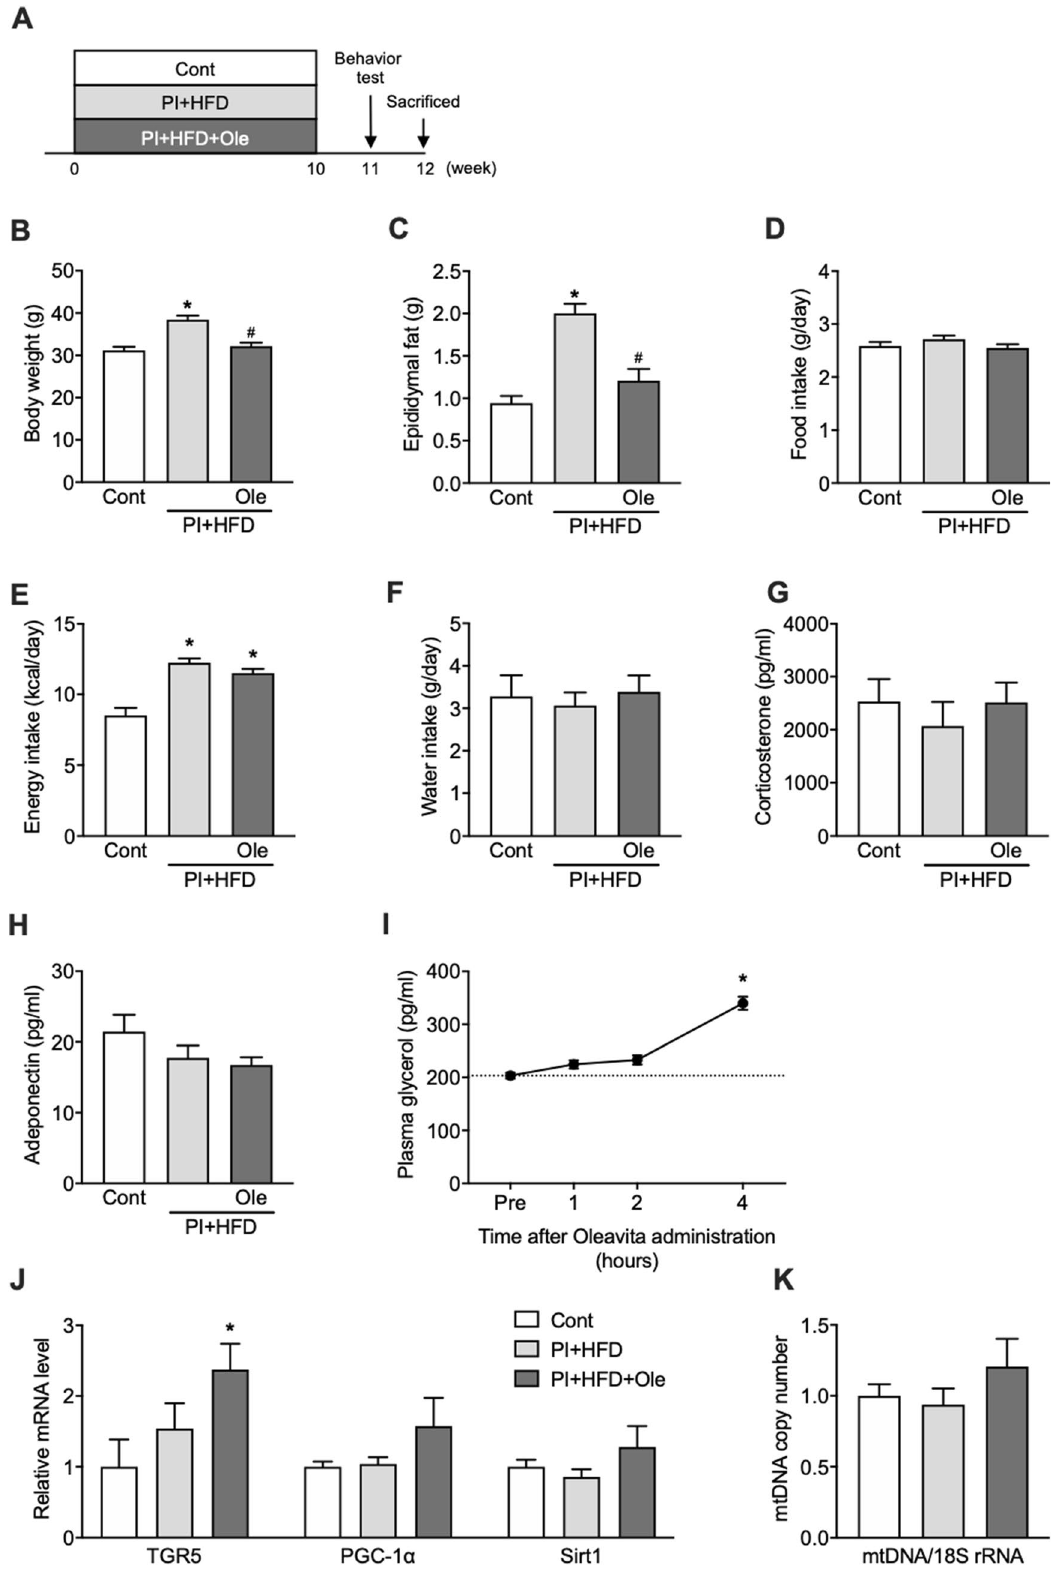
Figure 1. Olive leaf extract prevented gains in body weight and epididymal fat tissue. ( A ) Experimental protocol, ( B ) body weight, ( C ) epididymal adipose fat (EDF) mass, ( D ) food intake, ( E ) energy intake, ( F ) water intake, ( G ) plasma corticosterone concentration, ( H ) plasma adiponectin concentration, ( I ) plasma glycerol concentration after oral administration of olive leaf extract, ( J ) mRNA expression levels of TGR5 , PGC-1α , and Sirt1 in the EDF by real-time polymerase chain reaction, ( K ) mtDNA copy number in EDF. PI + HFD: physical inactivity (PI) + high-fat diet (HFD), PI + HFD + Ole: PI + HFD + Olive leaf extract. Data are expressed as mean ± SEM. *p < 0.05 vs control, # p < 0.05 vs PI + HFD, as determined by one-way